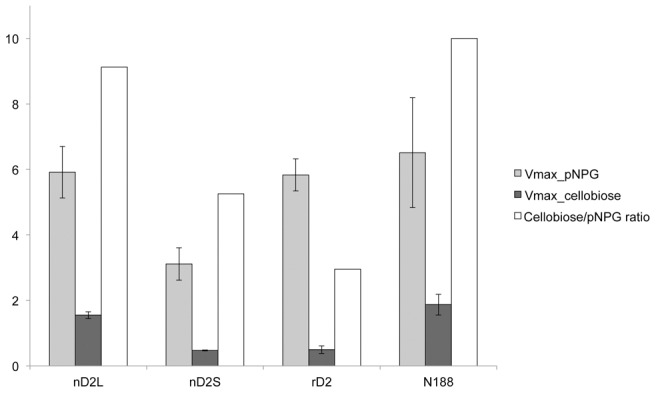
nD2L is more active toward cellobiose than small forms of D2.Maximum activity ratio of D2 variants toward cellobiose and pNPG. Activity data were complied from at least 3 independent experments. The difference between nD2L and nD2S is statistically significant (p <0.0002) by Welch's t-test. Error bars indicate standard error of the mean.